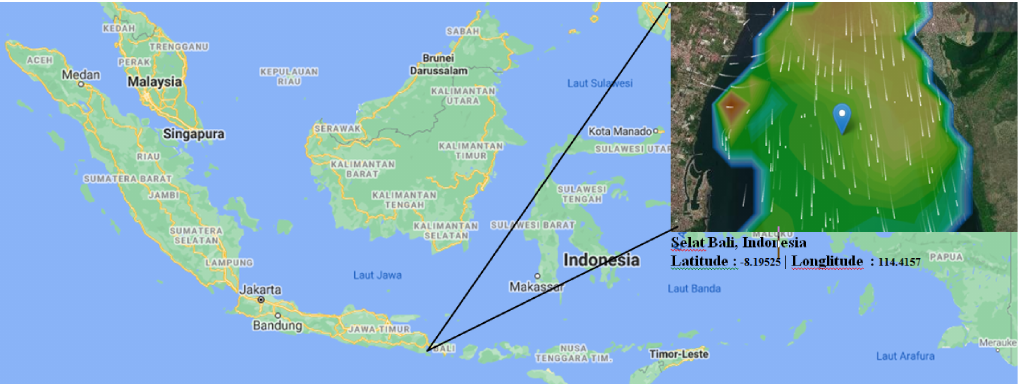
Fig. 4 Coordinate Point of the Bali Strait TABLE 3 DATA SAMPLE OF O CEAN S URFACE C URRENT V